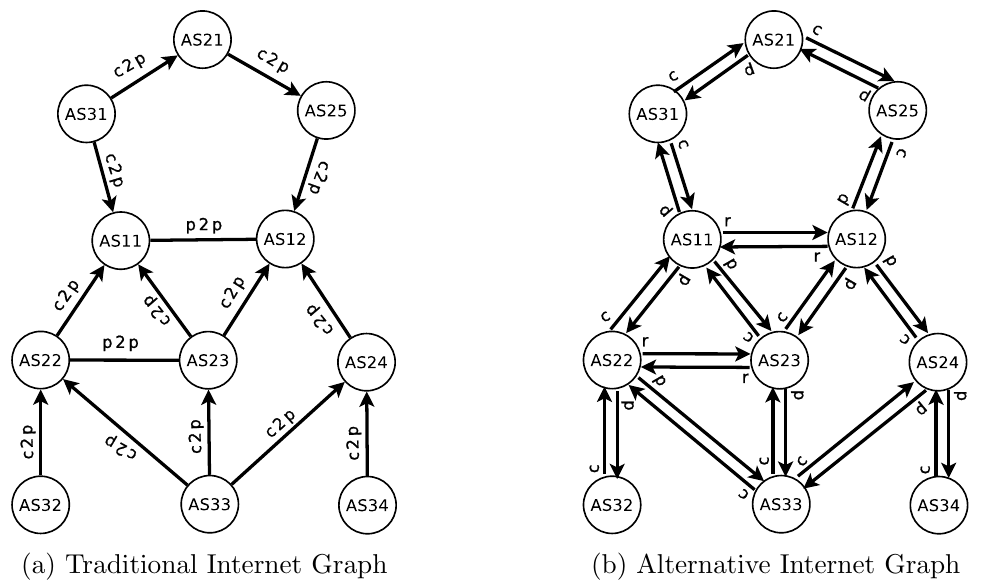
Figure 2: Different graph representations of the example AS-level Internet Topology map given in Figure